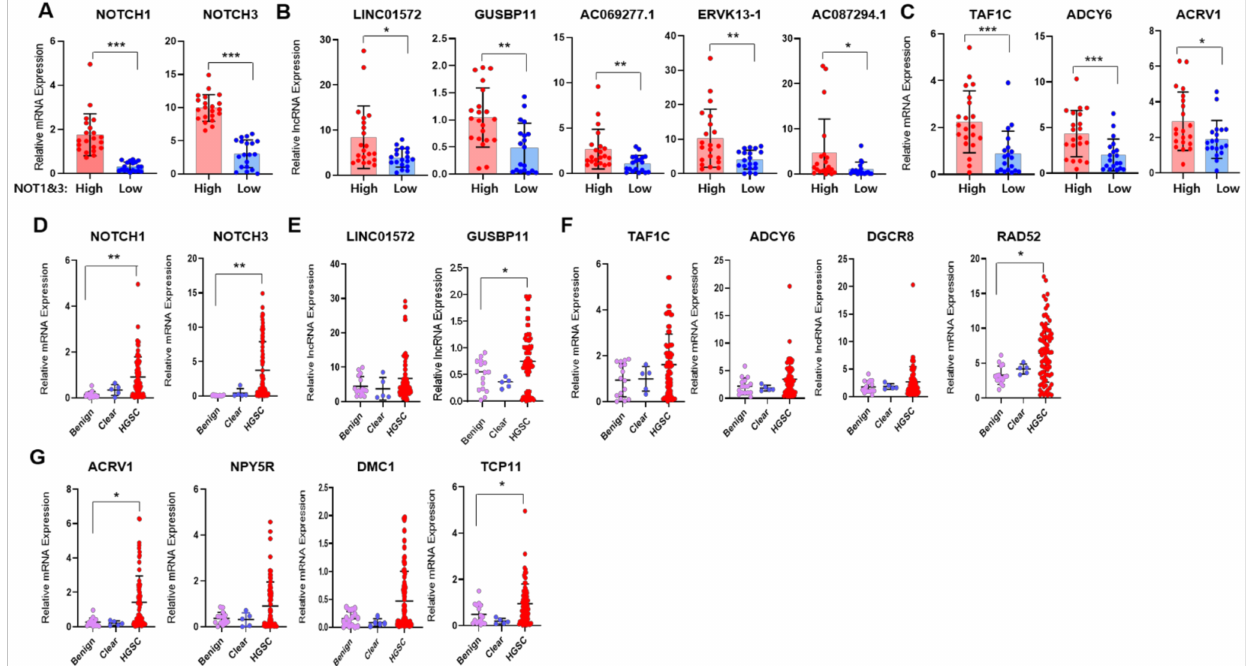
Figure 4. Validation of in silico analysis and transcriptome data in human ovarian tissue samples. ( A – C ) Comparisons of the relative expression of NOTCH1/NOTCH3 ( A ), representative Notch- related lncRNAs ( B ), genes related to DNA repair (TAF1C and ADCY6) and spermatogenesis ( C ). (ACRV1) using our own HGSC tissue samples according to NOTCH1/3 expression (high vs. low, n = 21 vs. n = 19, respectively). ( D – G ). Relative expression values of NOTC1/3 ( D ), notch-related lncRNAs ( E ), and representative genes related to DNA repair ( F ), and spermatogenesis ( G ), in benign or borderline ovarian tumors ( n = 16), clear cell ovarian carcinomas ( n = 5), and high-grade serous ovarian cancers (HGSC, n = 79). Data was shown as mean ± SD and p -values were calculated by two- tailed Mann–Whitney U-test. All experiments were repeated three times, and each experiment was performed in triplicate. * p < 0.05, ** p < 0.01, *** p < 0.001. Abbreviations: TAF1C, TATA-Box Binding Protein Associated Factor; ADCY6, Adenylate Cyclase Type 6; DGCR8, DiGeorge Syndrome Critical Region Gene 8; RAD52, DNA Repair Protein RAD52 Homolog; ACRV1, Acrosomal Vesicle Protein 1; NPY5R, Neuropeptide Y Receptor Y5; DMC1, DNA Meiotic Recombinase 1; TCP11, T-Complex